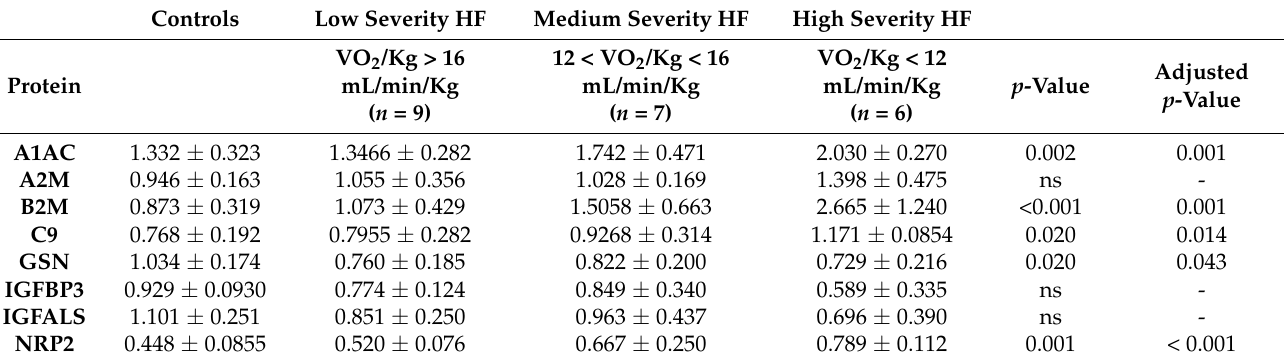
Table 1. Levels of the selected features in healthy controls and HF patients, categorized according to different disease severity (VO 2 /Kg). p -values from ANOVA, and adjusted p -value obtained with a general linear model adjusting for age.